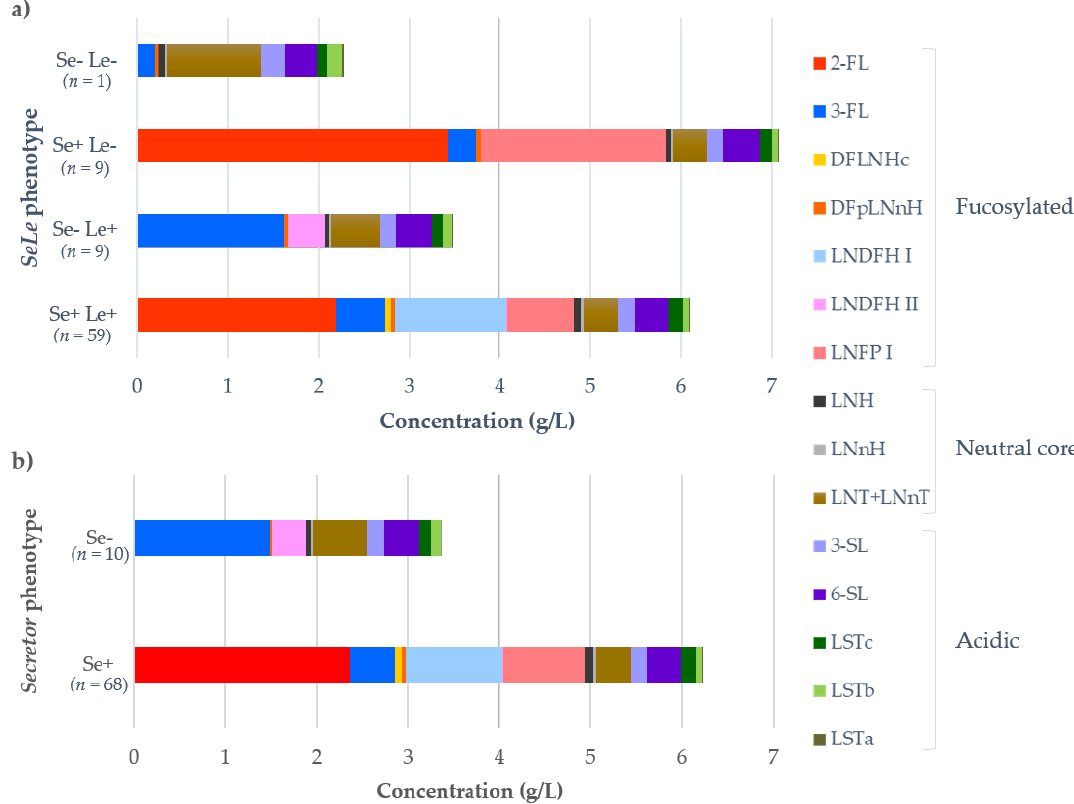
Figure 1. Human milk oligosaccharides (HMOs) profile and concentrations in human milk according to the SeLe ( a ) and Se ( b ) phenotype of the lactating mother.